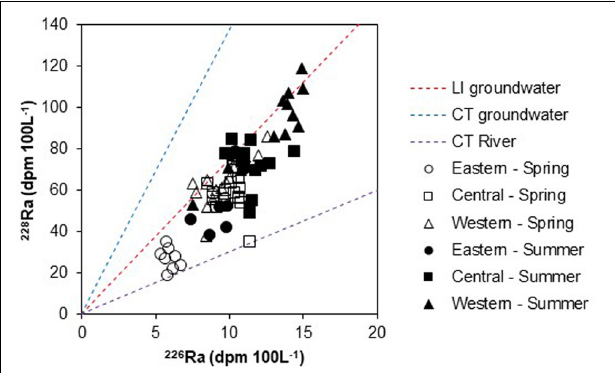
FIGURE 3 | Cross-plot of 228 Ra and 226 Ra activities in shallow and deep waters collected from Long Island Sound, arranged by sampling season. Note that error bars are generally smaller than the symbol size. Dashed lines indicate the 228 Ra/ 226 Ra activity ratio of possible Ra sources. Data sources: Connecticut River (AR = 3; Dion, 1983); Connecticut marine groundwater (AR = 14 ± 4; this study); and Long Island marine groundwater (AR = 8 ± 3; Tamborski et al., 2017a).